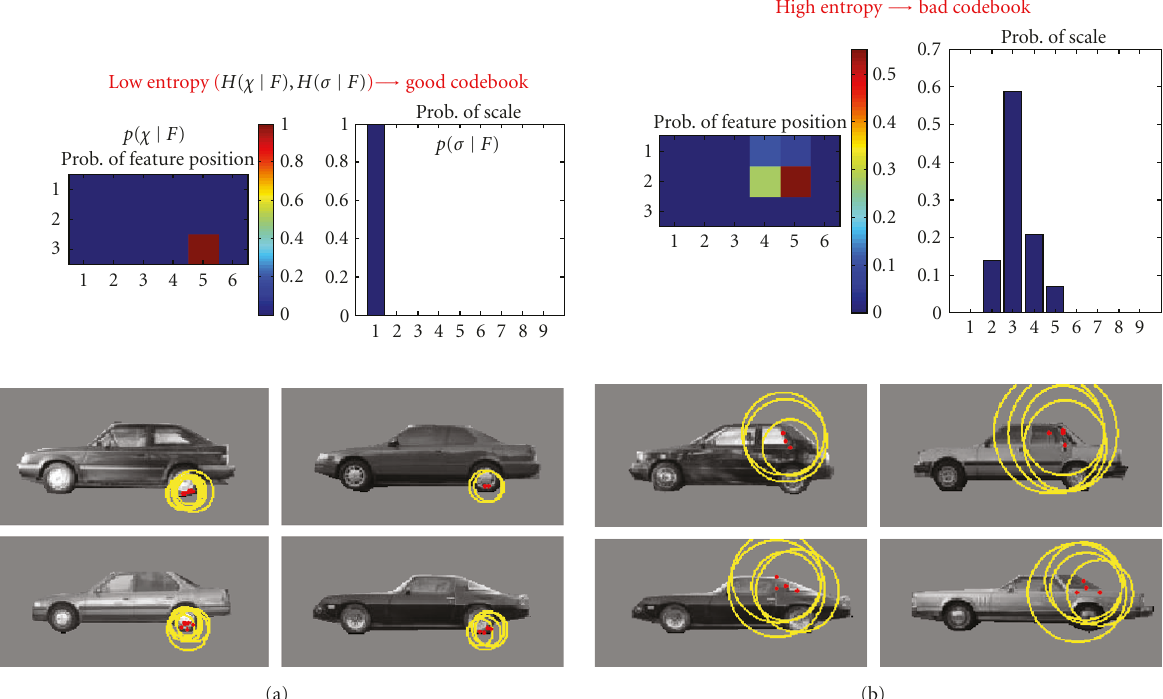
Figure 17: Probability distribution of a codeword pose (position and scale) and its corresponding parts. We select the final codebook whose pose entropy is